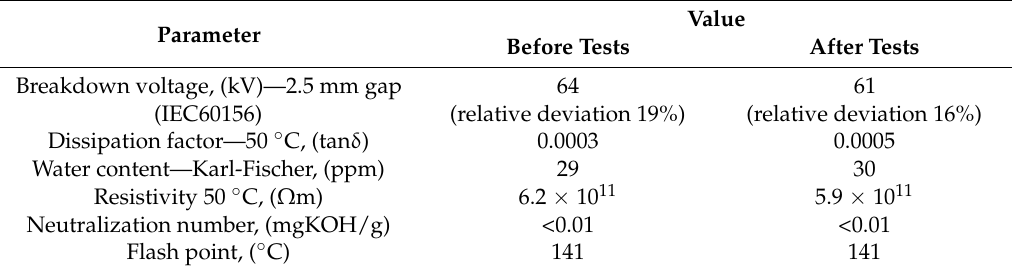
Table 1. Basic physical and chemical properties of the applied